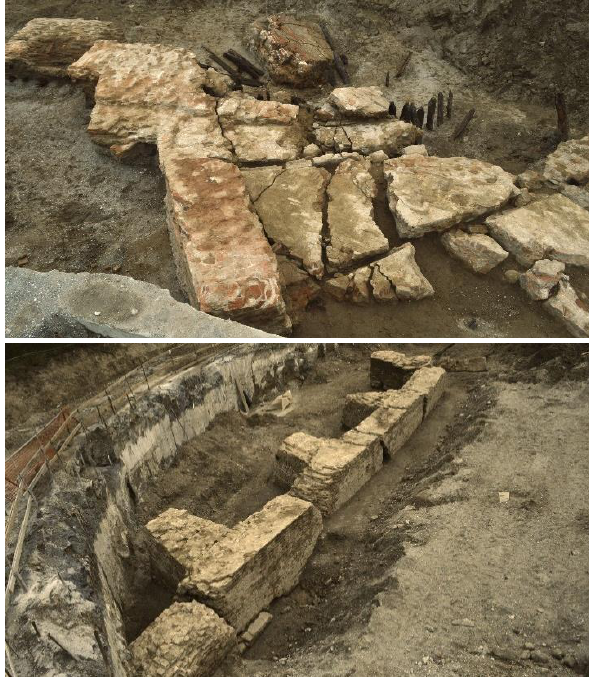
Figure 6. Historical maps of Pizzighettone. Above: map of 1724: in the red circle the area of the mill. Below: map of 1730. Left: the area of the watermill with the topographic name “Molino”. Right: vectorization and georeferencing of the